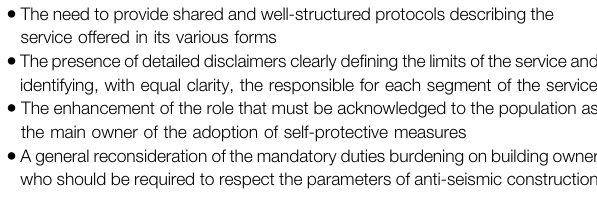
TABLE 2 | Solution